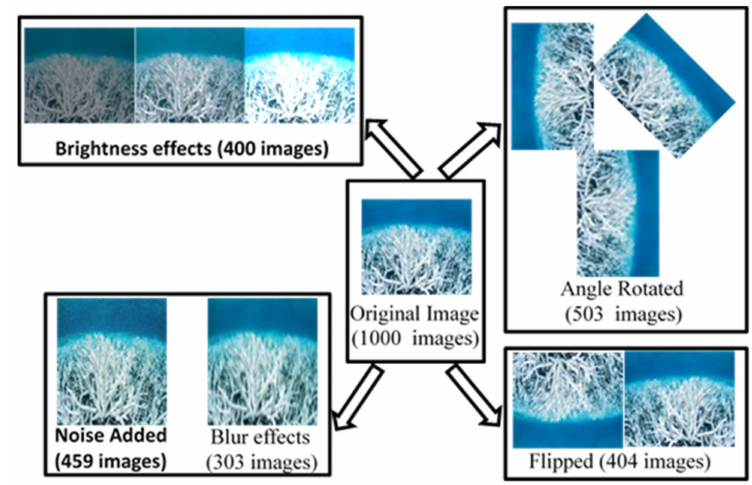
Figure 17. Training dataset generation through image augmentation process.